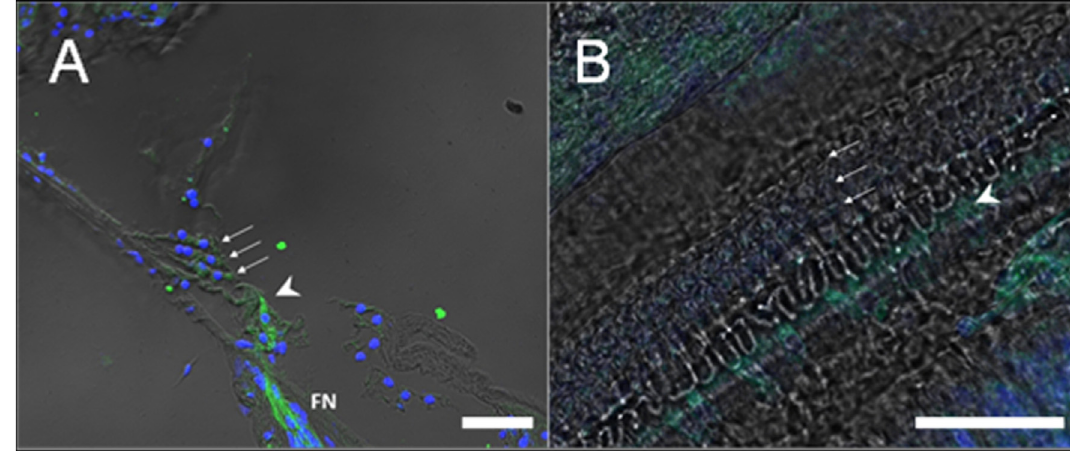
Fig 2. Detailed view of the sensory hair cells of the organ of Corti. Detailed view of the 3 rows of OHC (arrows) and the single row of IHC (arrowhead). (A) Mid-modiolar section. (B) Cochlear whole mount. Immunofluorescence labeling of CB 2 receptors is shown in green. To-Pro (blue) stains nuclei of cells. Intense fluorescence is observed in IHC (arrowhead), but not in OHC. Labeling of nerve fibers can be seen at the bottom of the figure (FN). IHC: inner hair cell. OHC: outer hair cell. (Scale bar = 30 μ m).